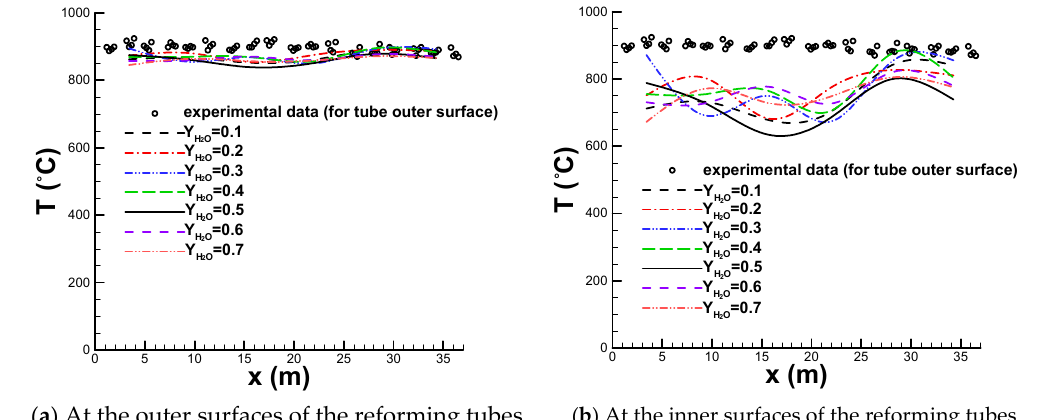
Figure 4. Comparison of the average temperatures at the surfaces of the reforming tubes using different mole fractions of steam.